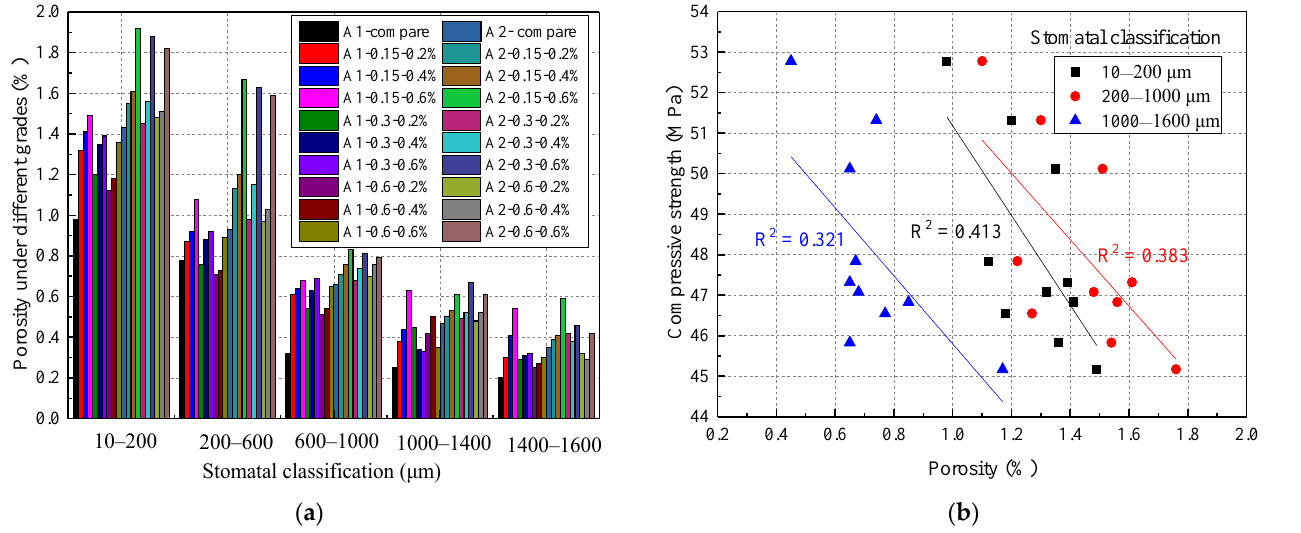
Figure 17. The effect of pore grading on concrete strength: ( a ) different graded porosity; ( b ) the relationship between porosity and compressive strength.